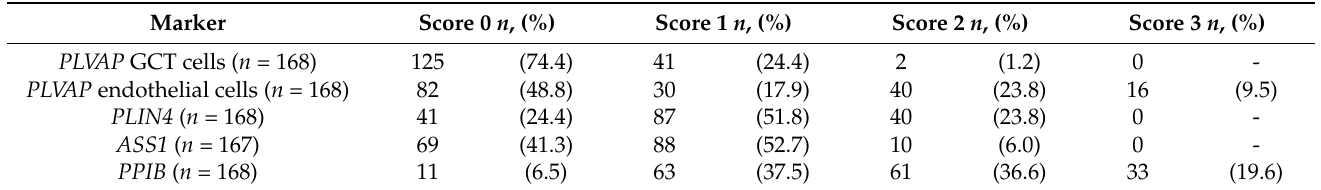
Table 2. Distribution of PLVAP , PLIN4 , ASS1 , and PPIB RNA in situ hybridization scores in AGCT TMA.